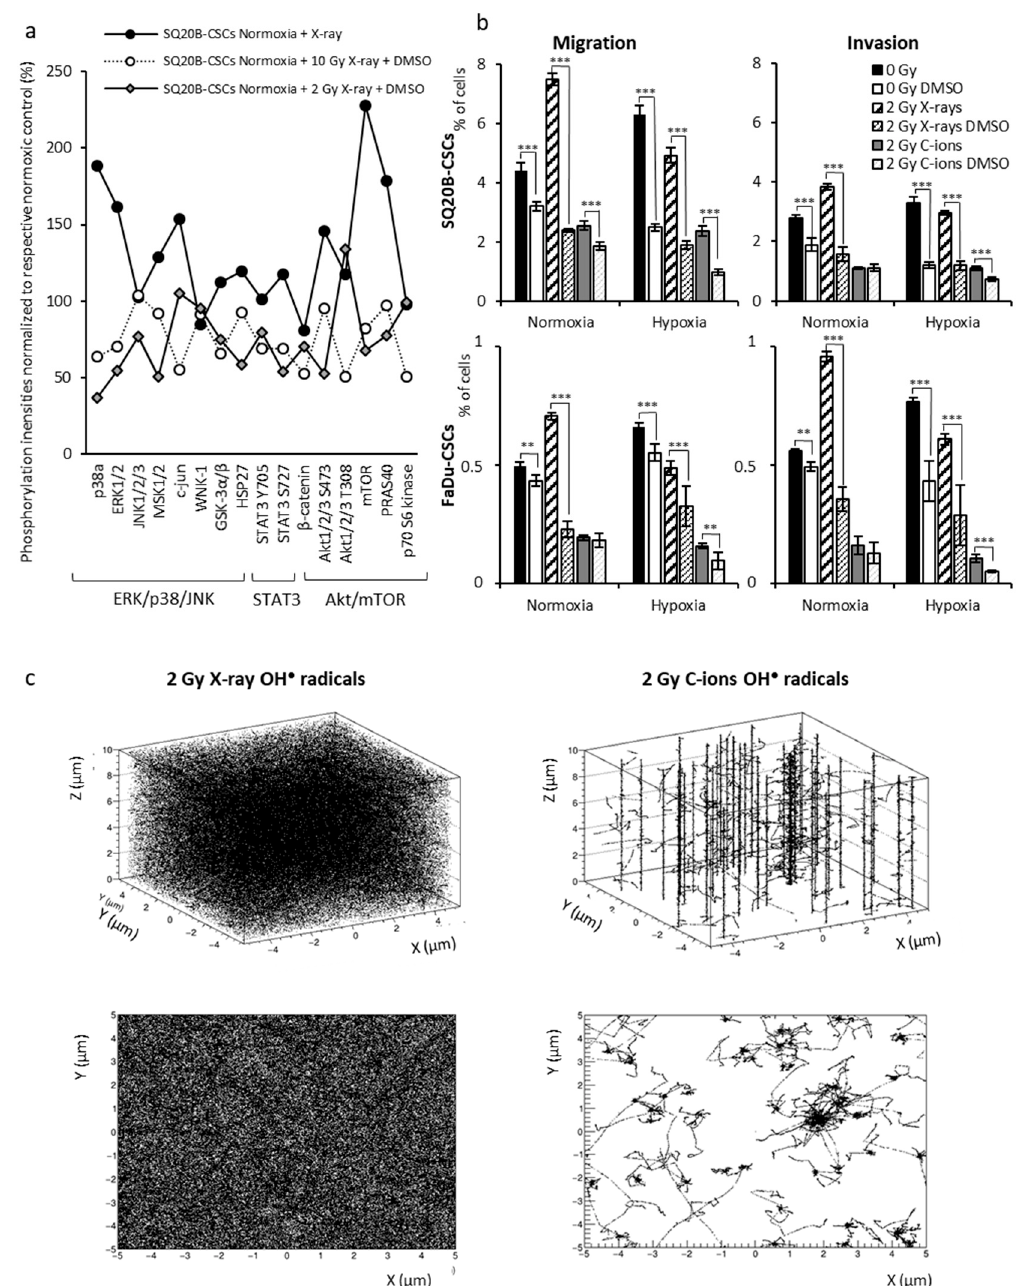
Figure 6. Impact of ROS production on CSC migration and invasion. ( a ) Phosphorylation signals obtained using the Proteome Profiler Human Phospho-Kinase Array Kit were normalized to those in normoxia for SQ20B-CSCs with or without treatment with 1% DMSO after 2 Gy or 10 Gy X-ray irradiation ( n ≥ 2 in duplicate). ( b ) Boyden chamber assays were performed in SQ20B-CSCs and FaDu-CSCs after 1% DMSO treatment ± 2 Gy X-ray or C-ion irradiation under normoxia or chronic hypoxia. (* p < 0.05, ** p < 0.01, *** p < 0.005, Student’s t test) ( n = 3). ( c ) HO (cid:8) radical distribution in response to X-rays and to a mixed radiation field reproducing the NIRS irradiation in C-ions Spread-Out Bragg Peak (SOBP) (dose-averaged Linear Energy Transfer (LET) ~13 keV / µ